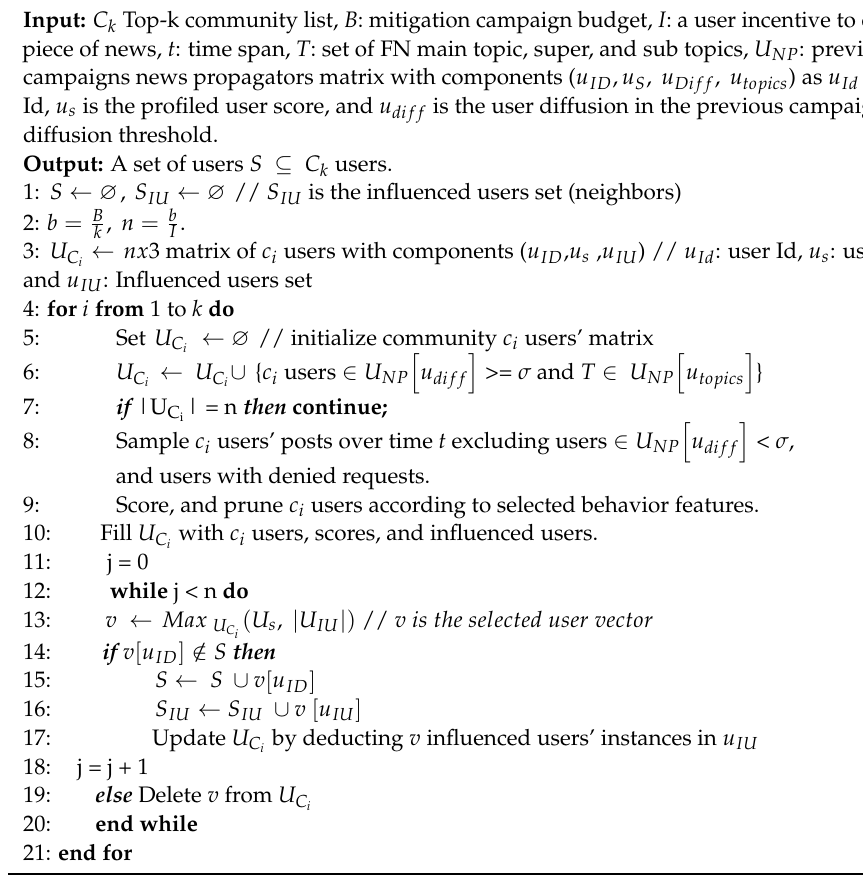
Algorithm 2. Greedy budget-based community user